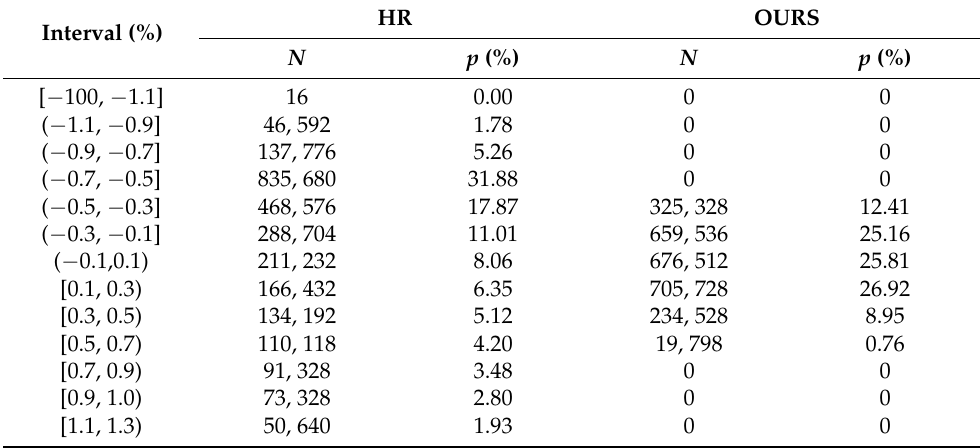
Table 9. The number of grids with refined D length interval of HR and OURS